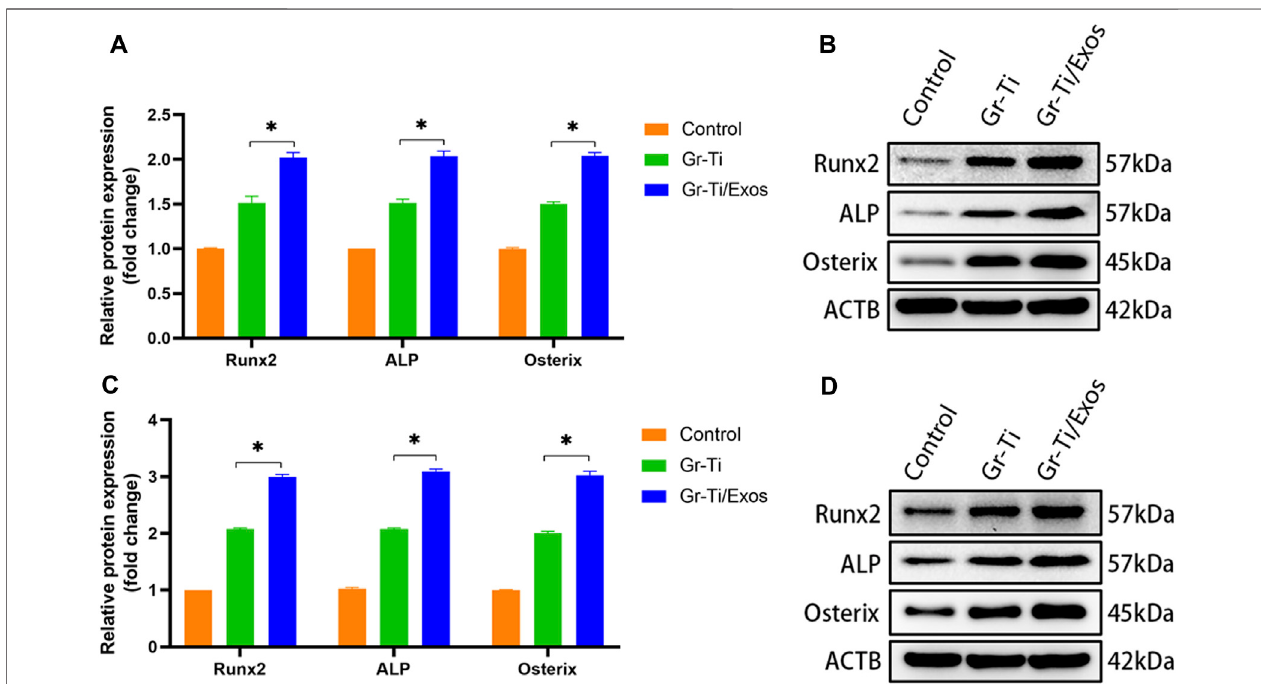
FIGURE 6 | Expression of osteogenic-related protein: (A,B) after osteogenic induction for 7 days; (C,D) after osteogenic induction for 14 days: the levels of RUNX2, ALP, and Osterix in the Gr-Ti/Exos group were higher than those in the Gr-Ti group at 7 and 14 days ( p p < 0.05).